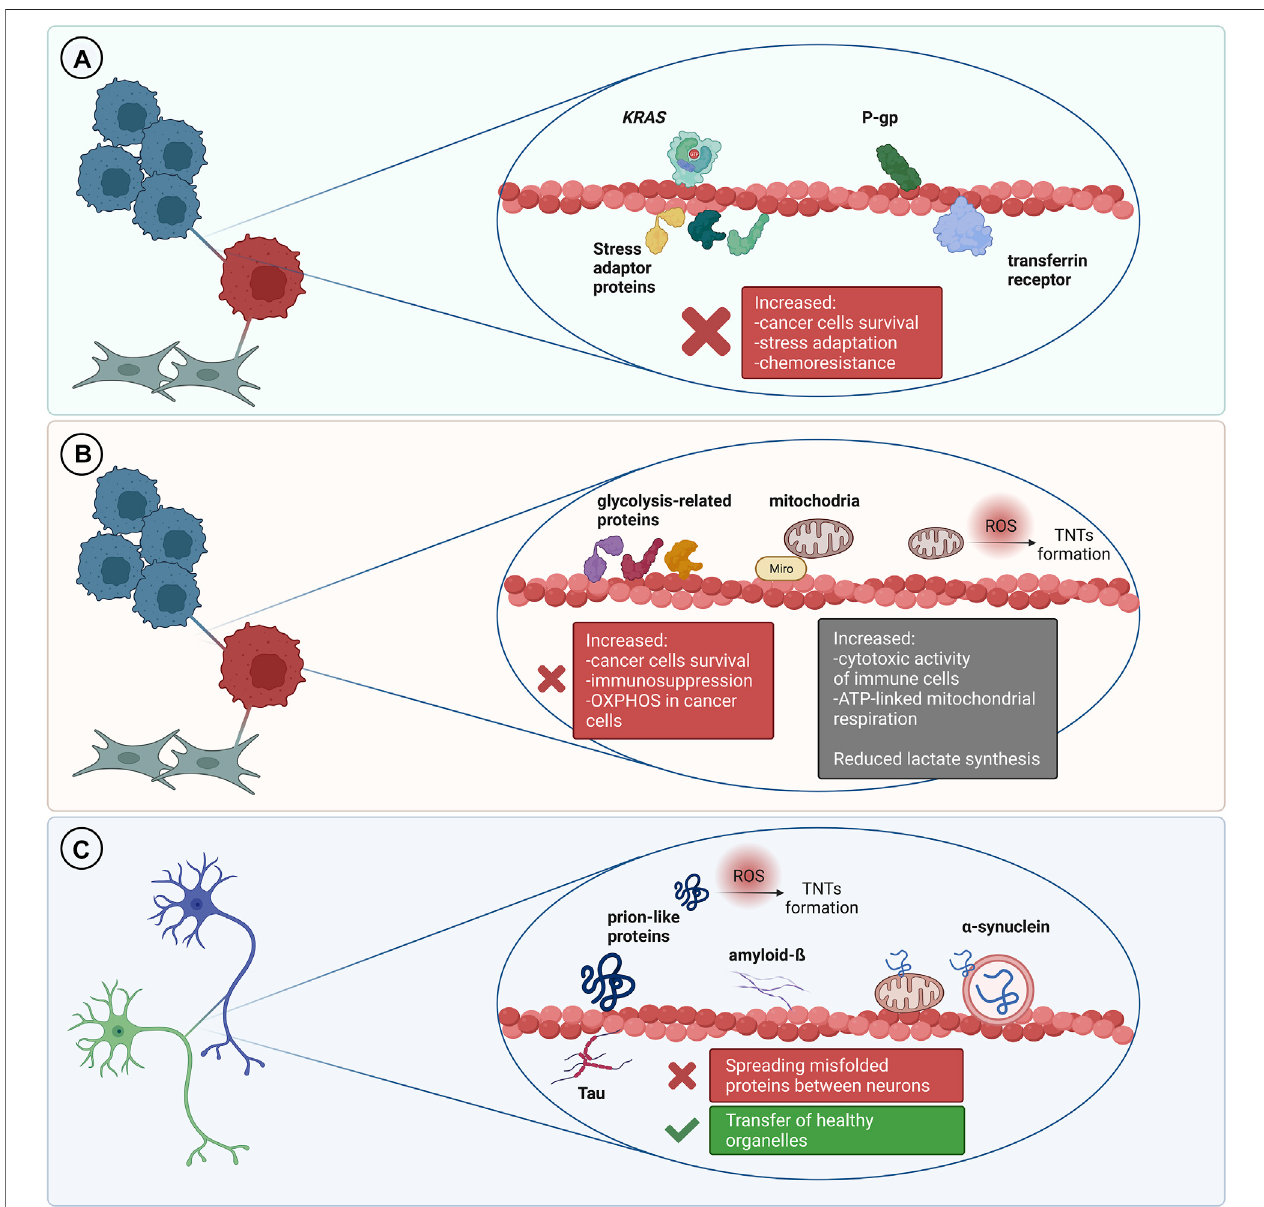
FIGURE 2 | TNT-mediated transfer of various proteins and its outcomes. (A) In the cancer microenvironment it is usually associated with cancer progression and increased chemoresistance. (B) Transfer of metabolic-related proteins and mitochondria may result in increased immunosuppression but it can also be a cause of increased cytotoxic activity of immune cells. Transfer of mitochondria to cancer cells is often associated with increased chemoresistance and cancer progression. (C) TNT can mediate transfer of misfolded proteins between cells in the nervous system which leads to progression of neurodegenerative disorders. On the other hand, TNT can be a route for the transmission of healthy organelles as a rescue